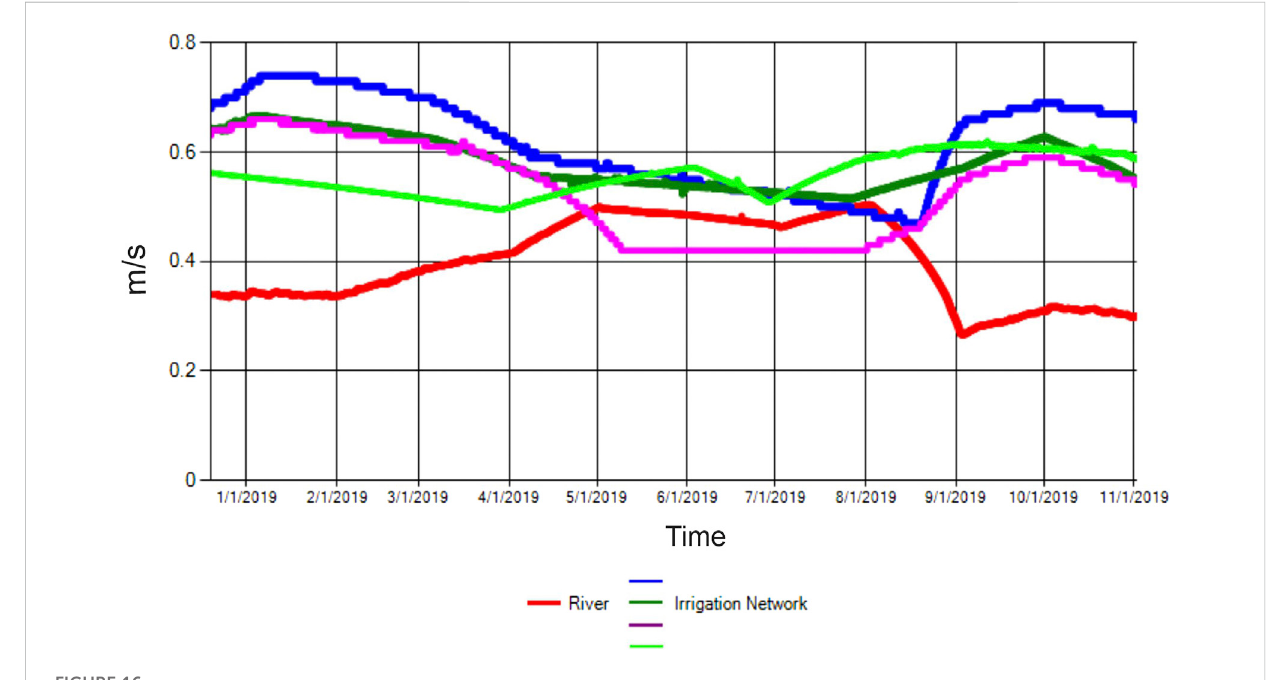
FIGURE 16 Velocity (m/s) as a function of time.